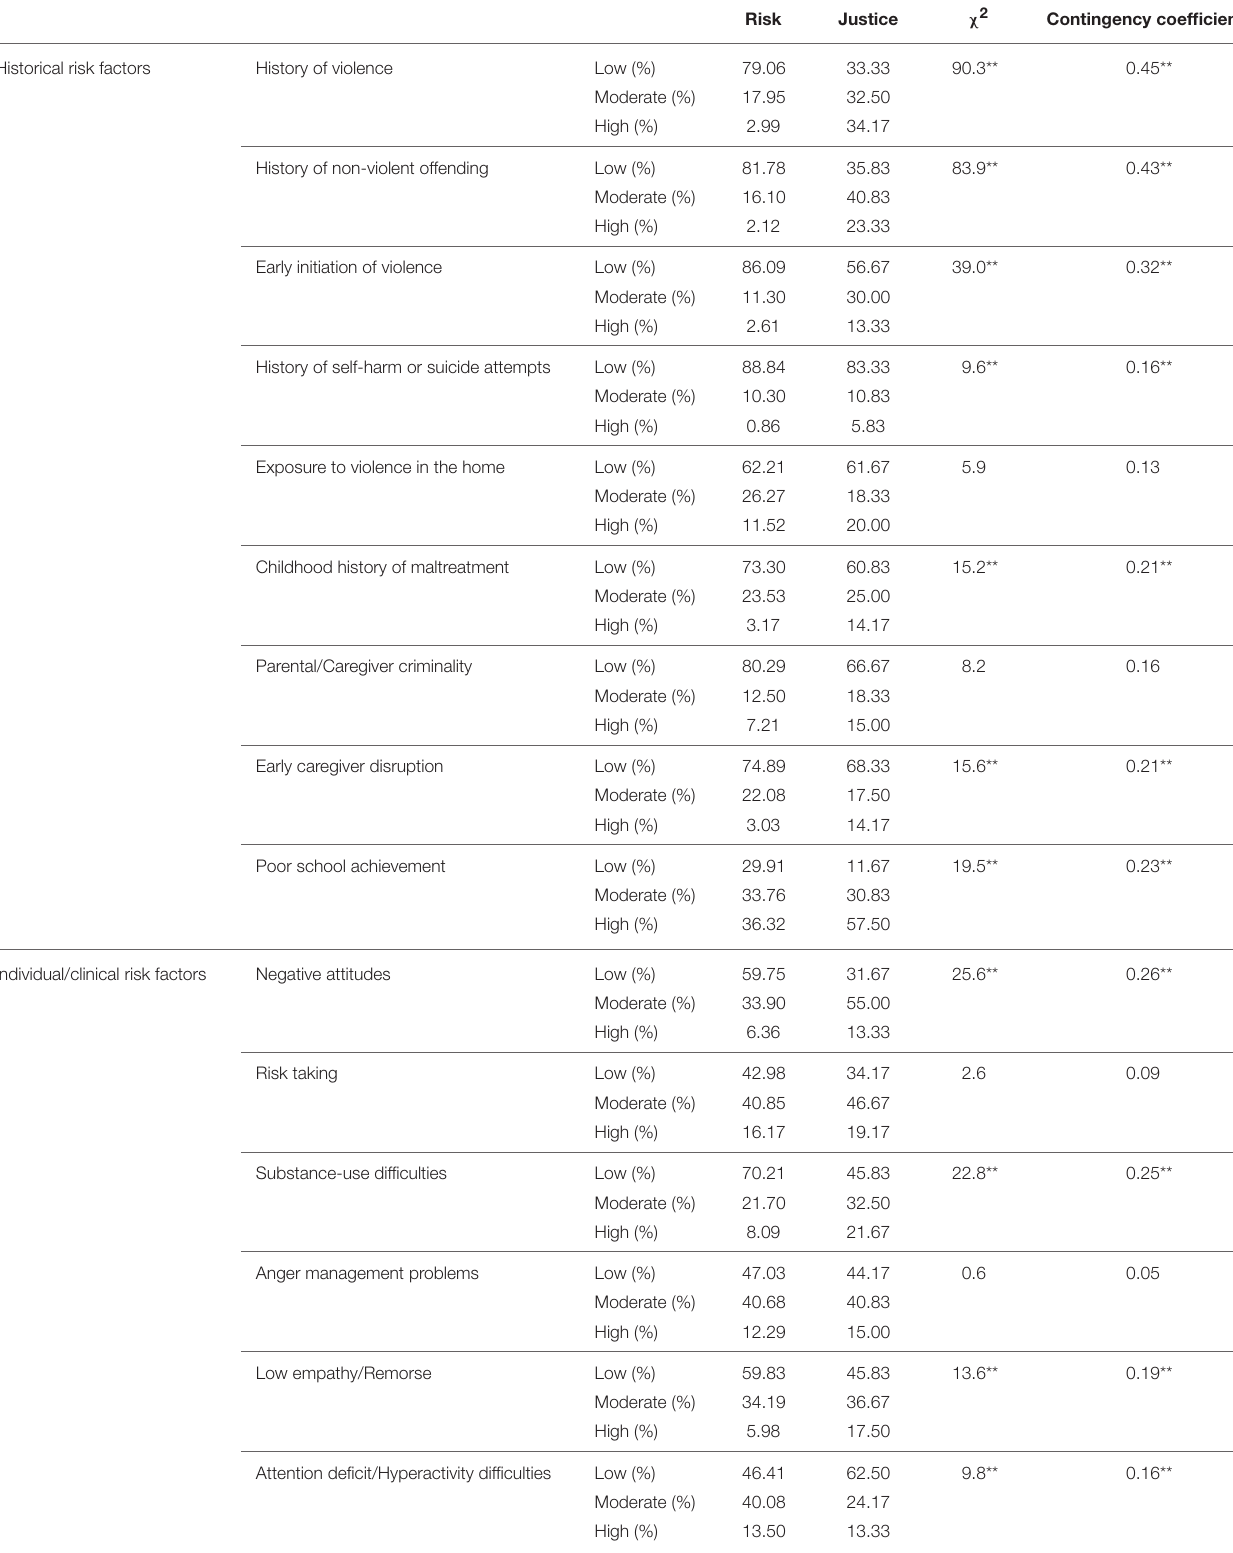
TABLE 7 | Percentage of adolescents with low, moderate, and high levels of risk factors in SAVRY, in juvenile justice, and risk samples.